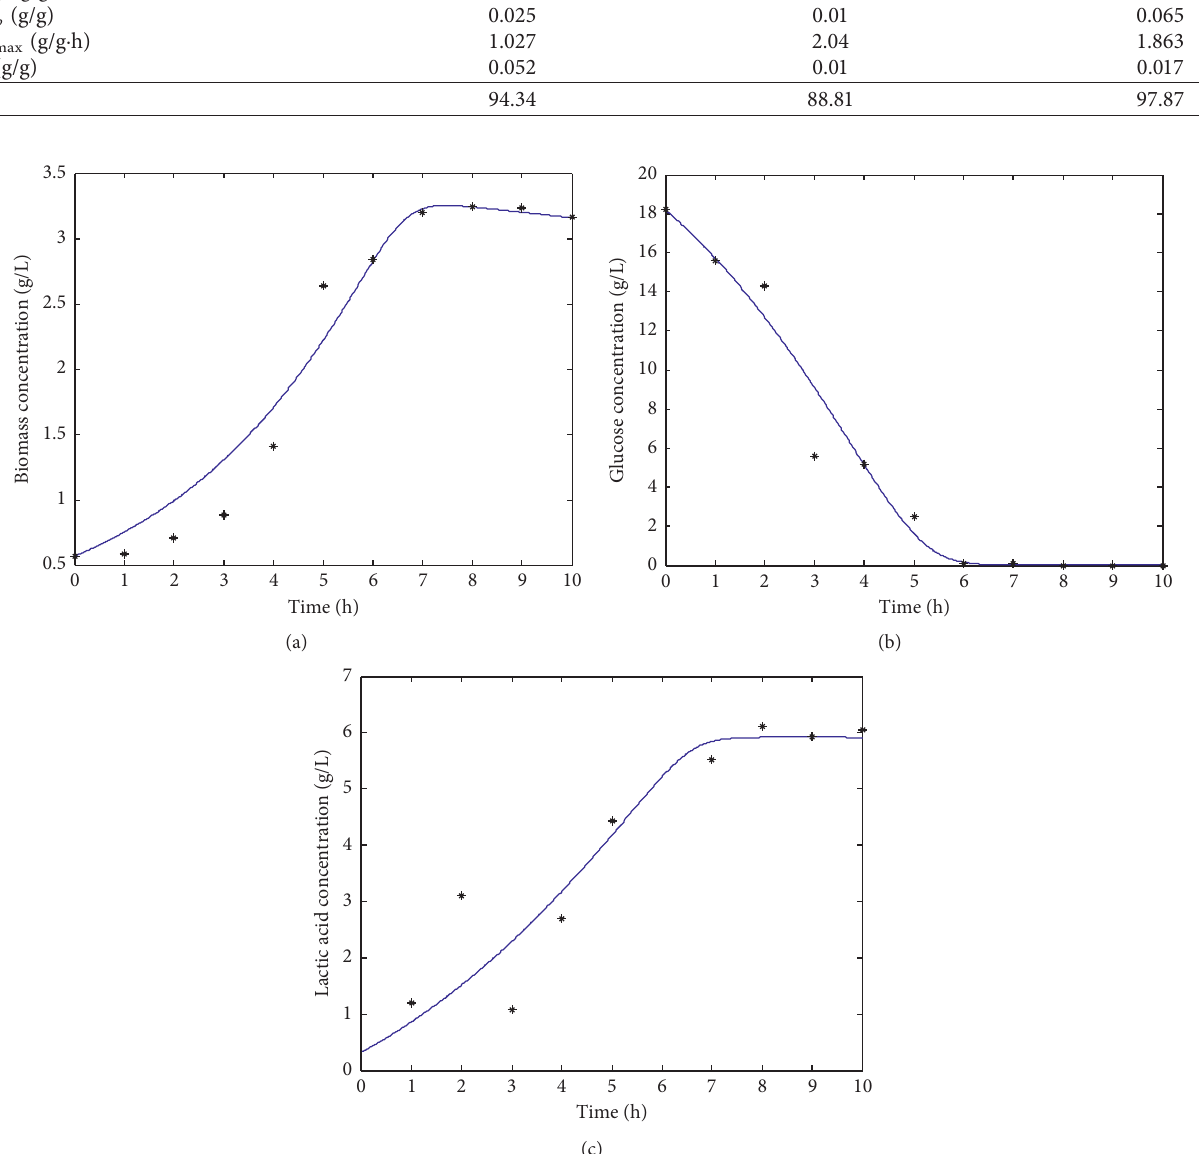
Figure 1: Experimental data (points) and simulation (lines) of biomass (a), glucose (b), and lactic acid (c) concentrations of 2 L bioreactor batch culture of Enterococcus faecalis SLT13 on M17 medium.